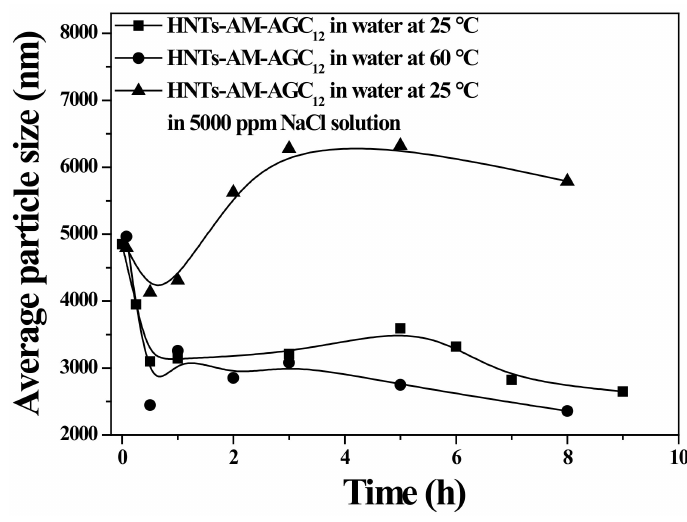
Figure 7. The particle size change during the aging of nanocontainers in water at different